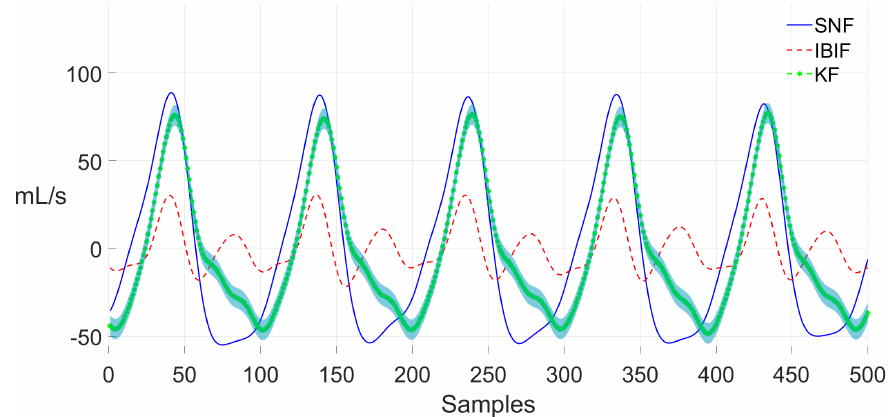
Figure 11. Section from the Rainbow passage (healthy female) with estimations of GVV: Kalman filter (solid and dot green), IBIF (dashed red), and single notch filter (solid blue). The estimation of GVV using Kalman filter includes ± 2 σ (standard deviation) on the green shaded region.